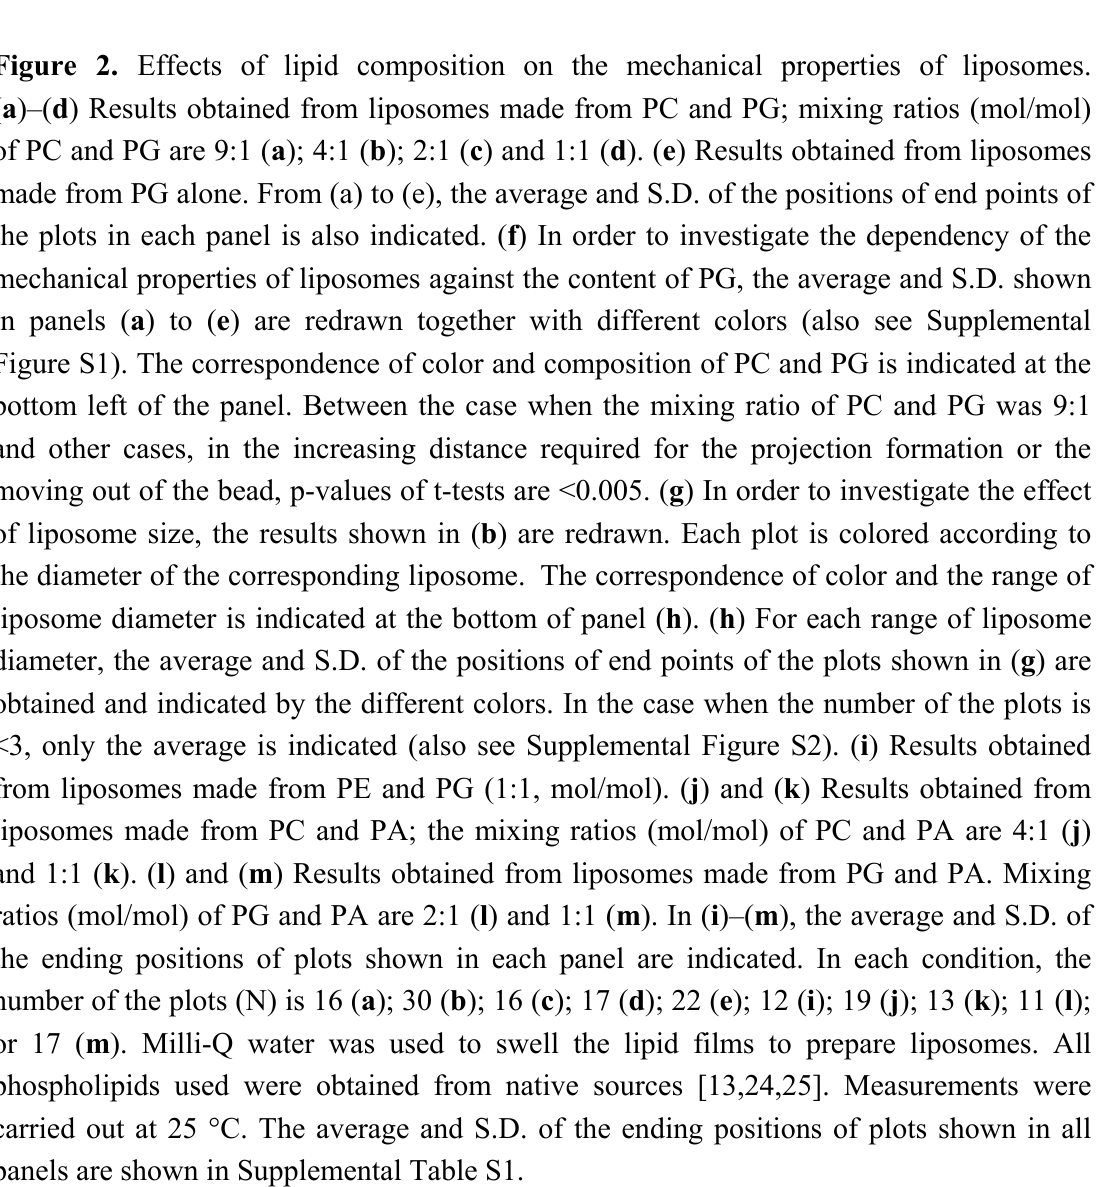
Figure 2. Effects of lipid composition on the mechanical properties of